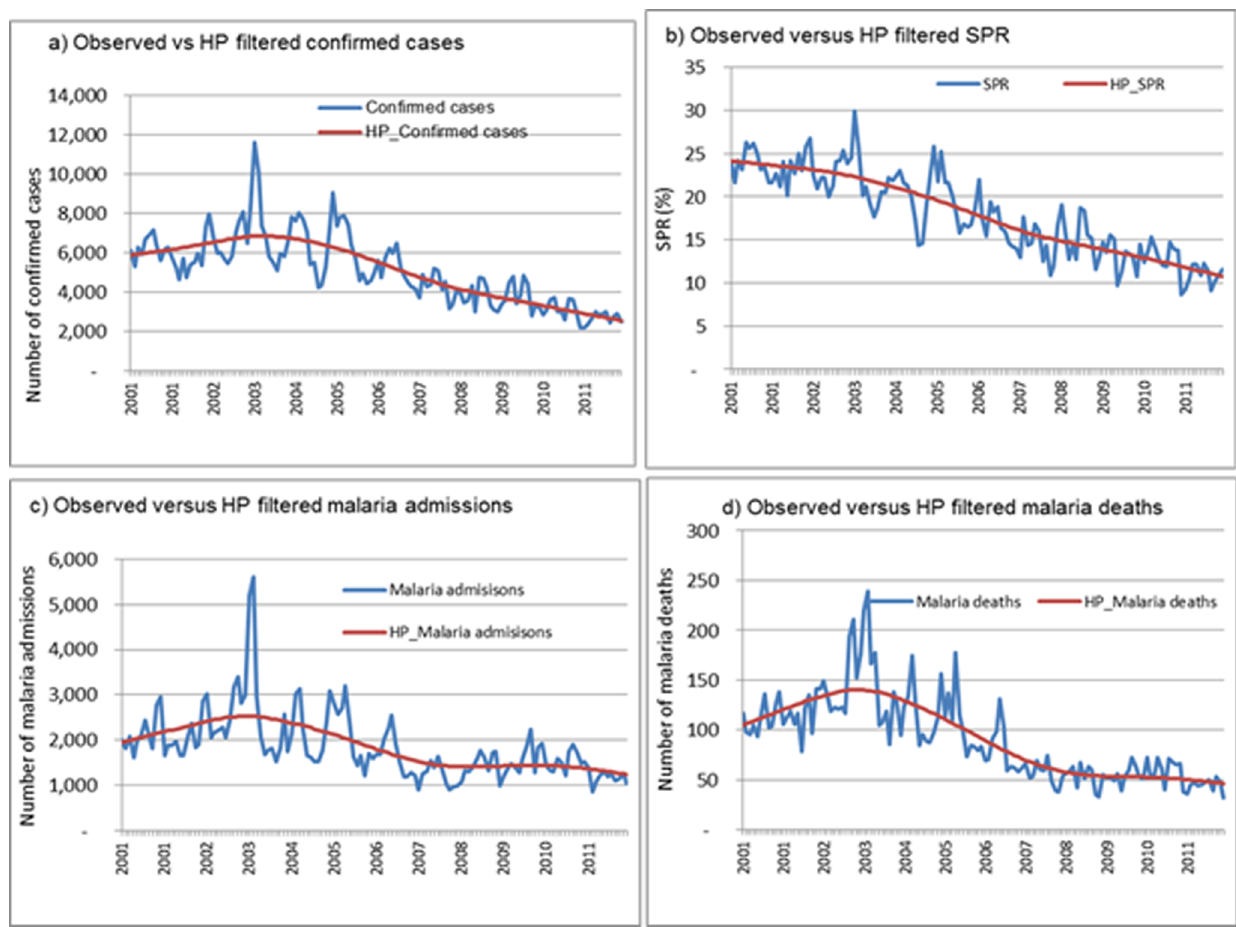
Figure 5. Time series of monthly confirmed malaria cases, slide positivity rate, admissions and deaths extracted by use of a Hodrick-Prescott filter with monthly smoothing parameter l =14,400 (HP = Hodrick-Prescott filter; MAl-IPDAll Ages = Inpatient malaria cases in all ages; Mal-DeathsAll Ages = Malaria deaths in all ages, SPRAll Ages = Slide positivity rate in all ages; PositiveAll ages = Number of confirmed cases).